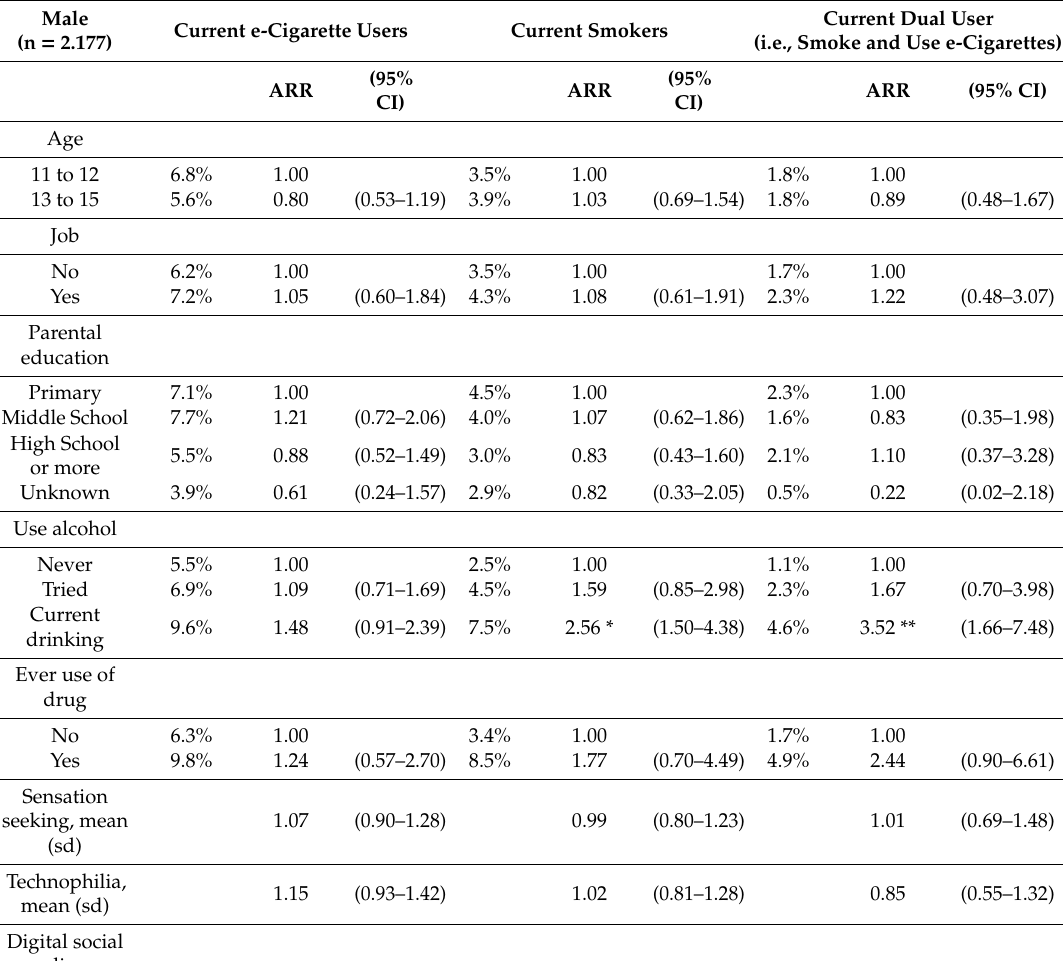
Risk factors for exclusive e-cigarette use, exclusive smoking, and dual use among males,